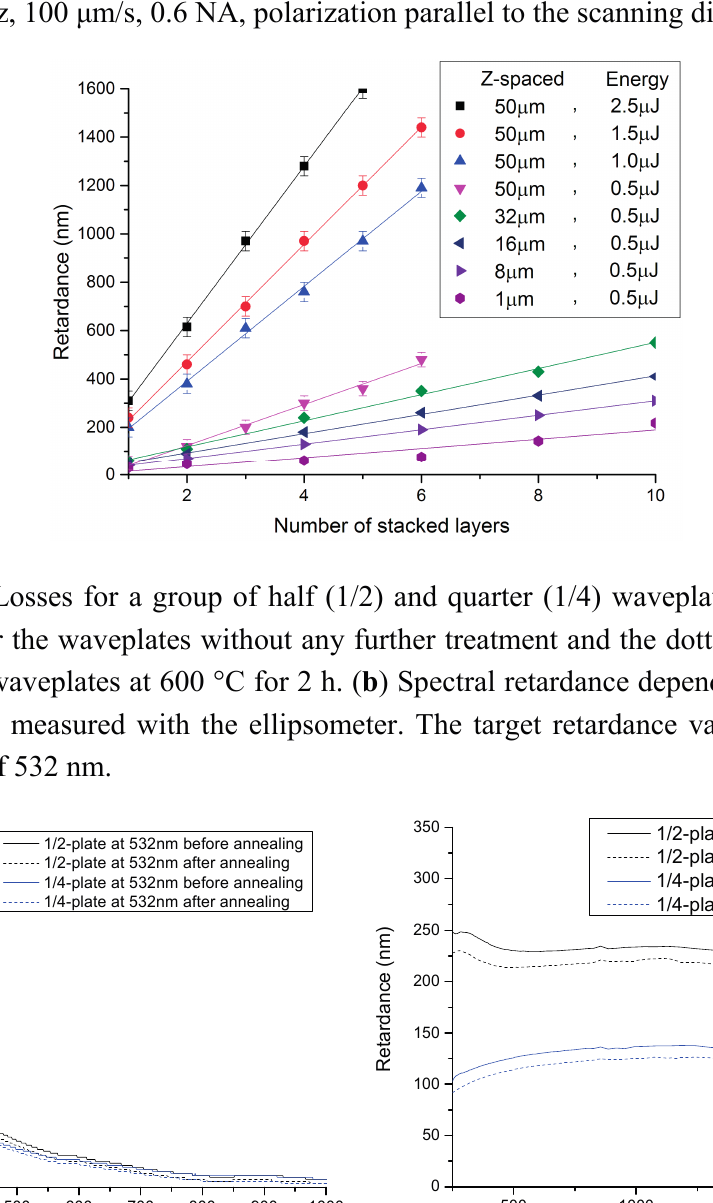
Figure 4. Retardance according to the number of stacked layers and their Z -spacing (spacing between consecutive layers in the propagation direction) for various pulse energies (1030 nm,